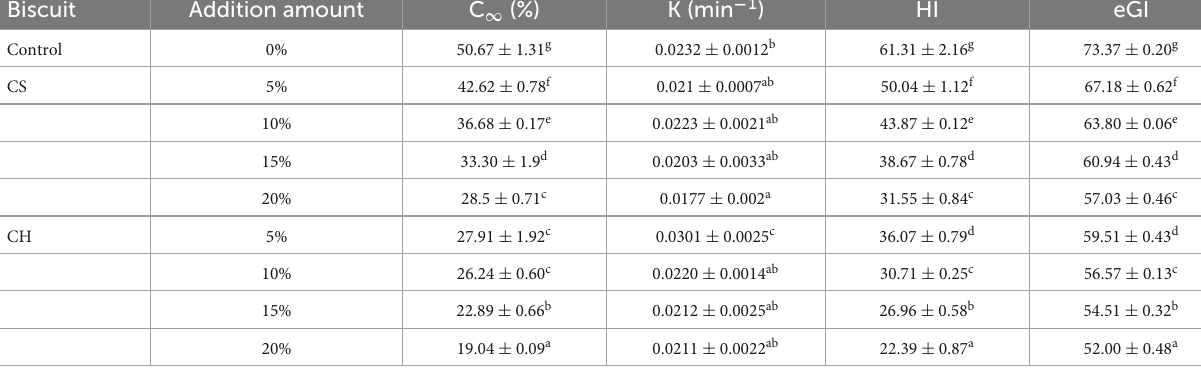
TABLE 3 Digestion parameters obtained from the digestibility kinetics of CH-biscuits and CS-biscuits. Biscuit Addition